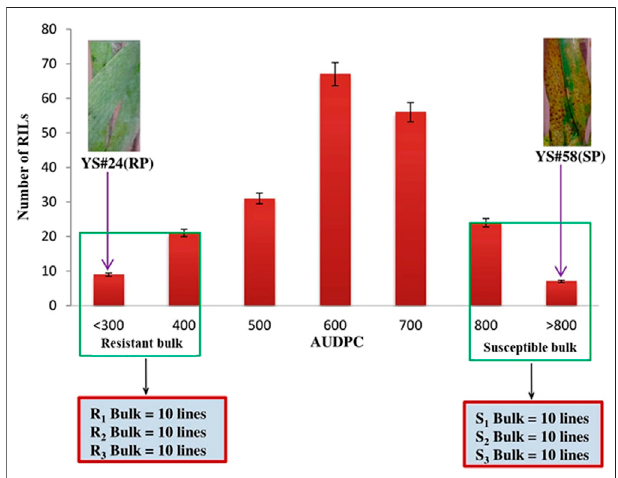
FIGURE 1 | Frequency distribution of the AUDPC of the wheat RIL populationandparents.Resistantparent(RP),YS#24,andsusceptibleparent (SP), YS#58 clearly show the phenotypic differences for SB disease severity. Resistant bulk (R1-bulk, R2-bulk, and R3-bulk) with lower AUDPC and susceptible (S1-bulk, S2-bulk, and S3-bulk) with higher AUDPC were selected from each